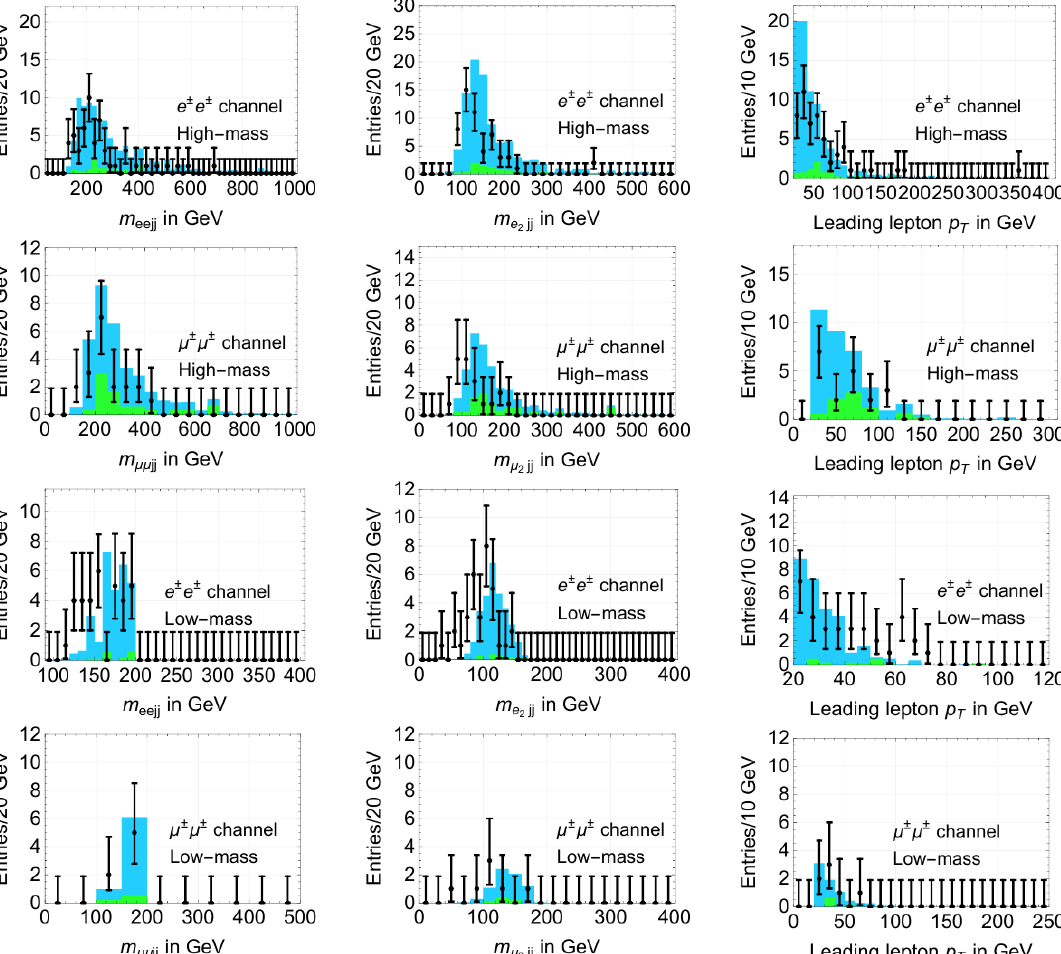
Figure 12 . Validation of the fake lepton simulation with heavy Majorana searches at 8 TeV in the high and low mass regions. The W + 3 j and QCD jets are colored in blue. The other subdominant processes with up to two matched jets are colored in green. Data points are taken from [123, 124], see text for